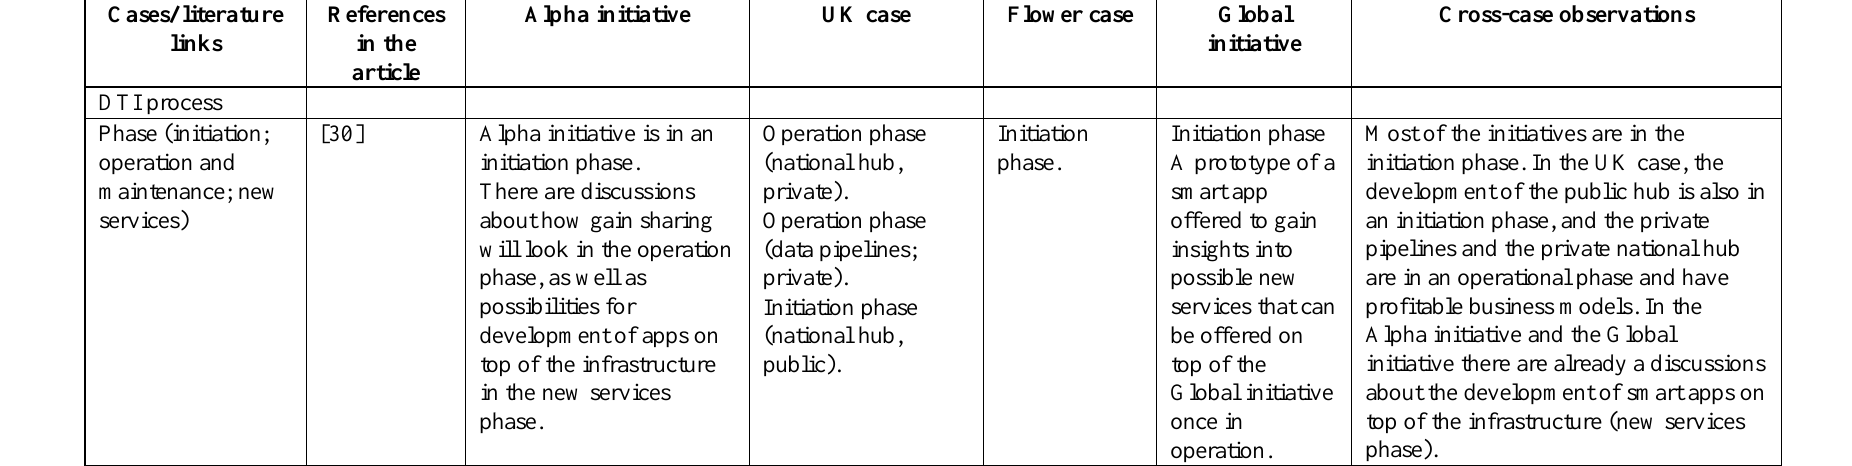
Table A2. The process component of the DTI framework and links to the four cases and the references of the article